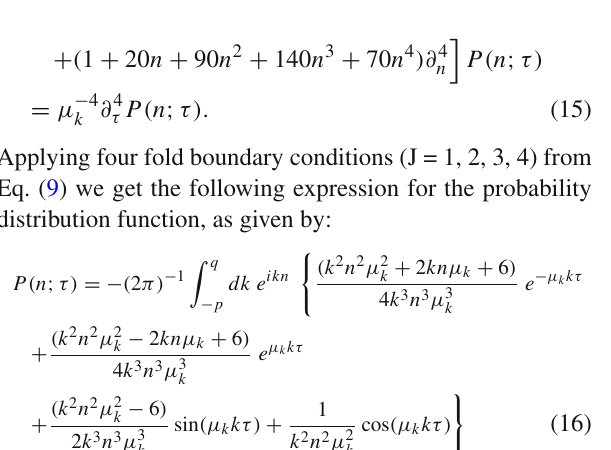
Fig. 1 Variation of fourth order quantum corrected probability distri- bution with respect to the particle number density